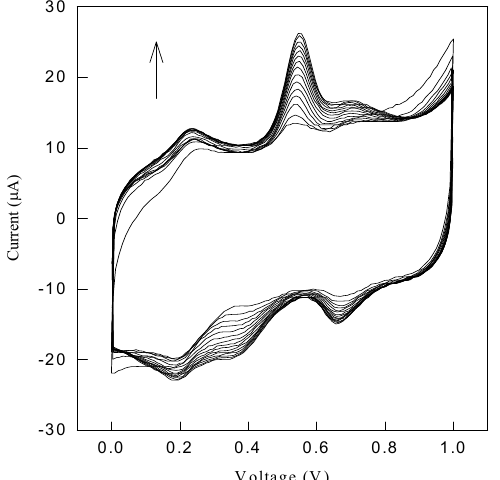
Figure 1. Cyclic voltammograms in the eletrodeposition of copper-cobalt hexacyanoferrate films from a solution of 0.5 M KCl, 0.33 mM CuCl